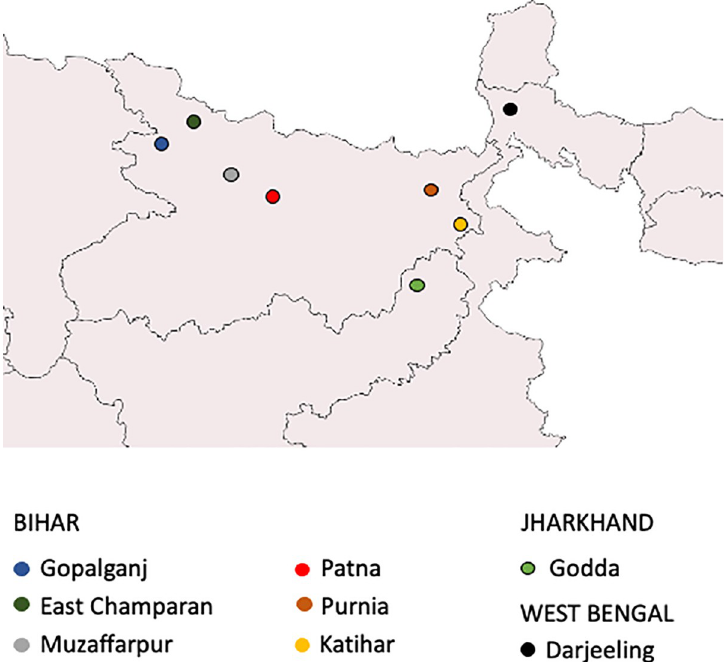
Fig 1. Map of the three VL endemic areas in India with the sentinel site districts labelled. (Base layers for map can be found at https://www.statsilk.com/maps/download-free-shapefile-maps).